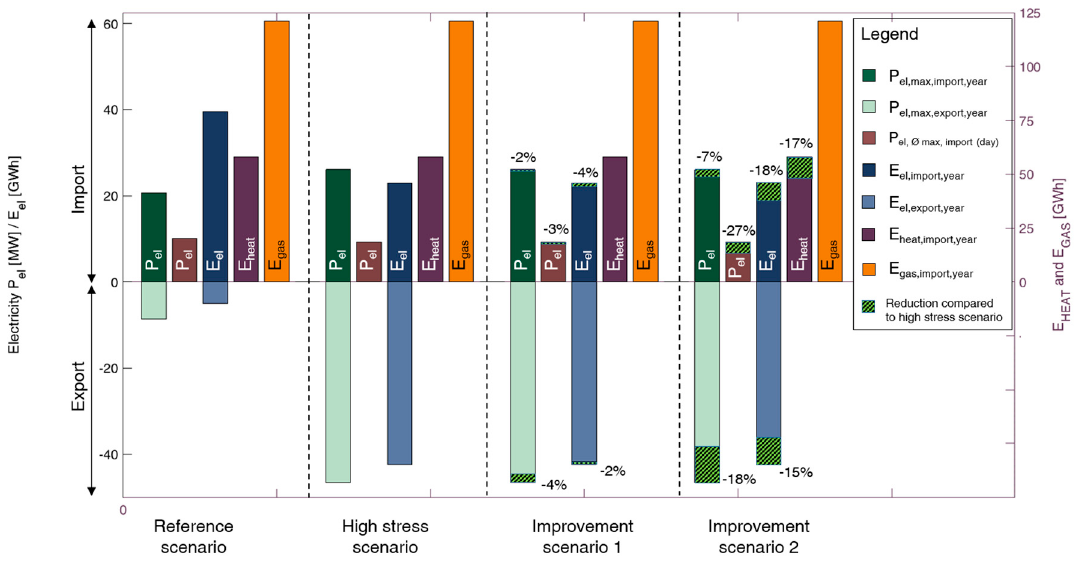
Figure 6. Topology of case study 1.